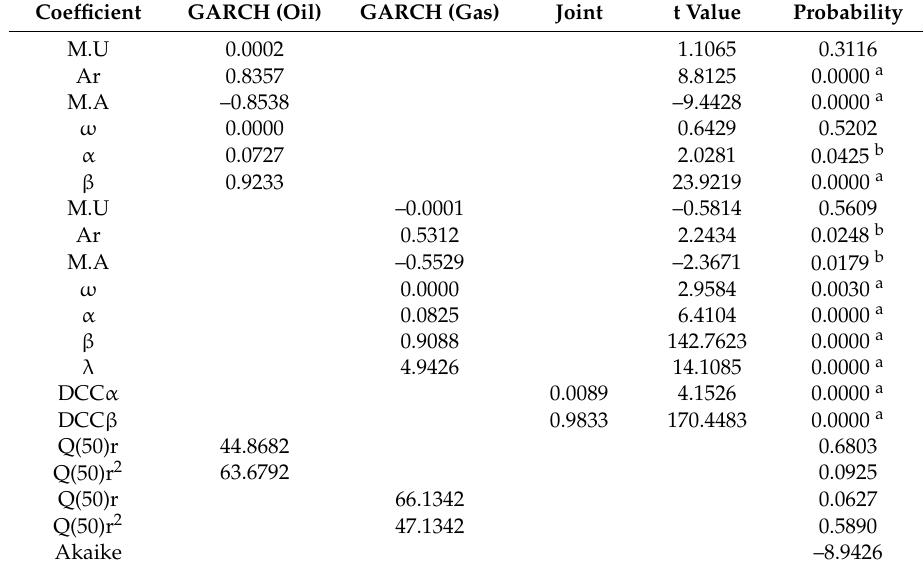
Table 6. Symmetrical Dynamic Conditional Covariance (DCC)-GARCH (1,1).